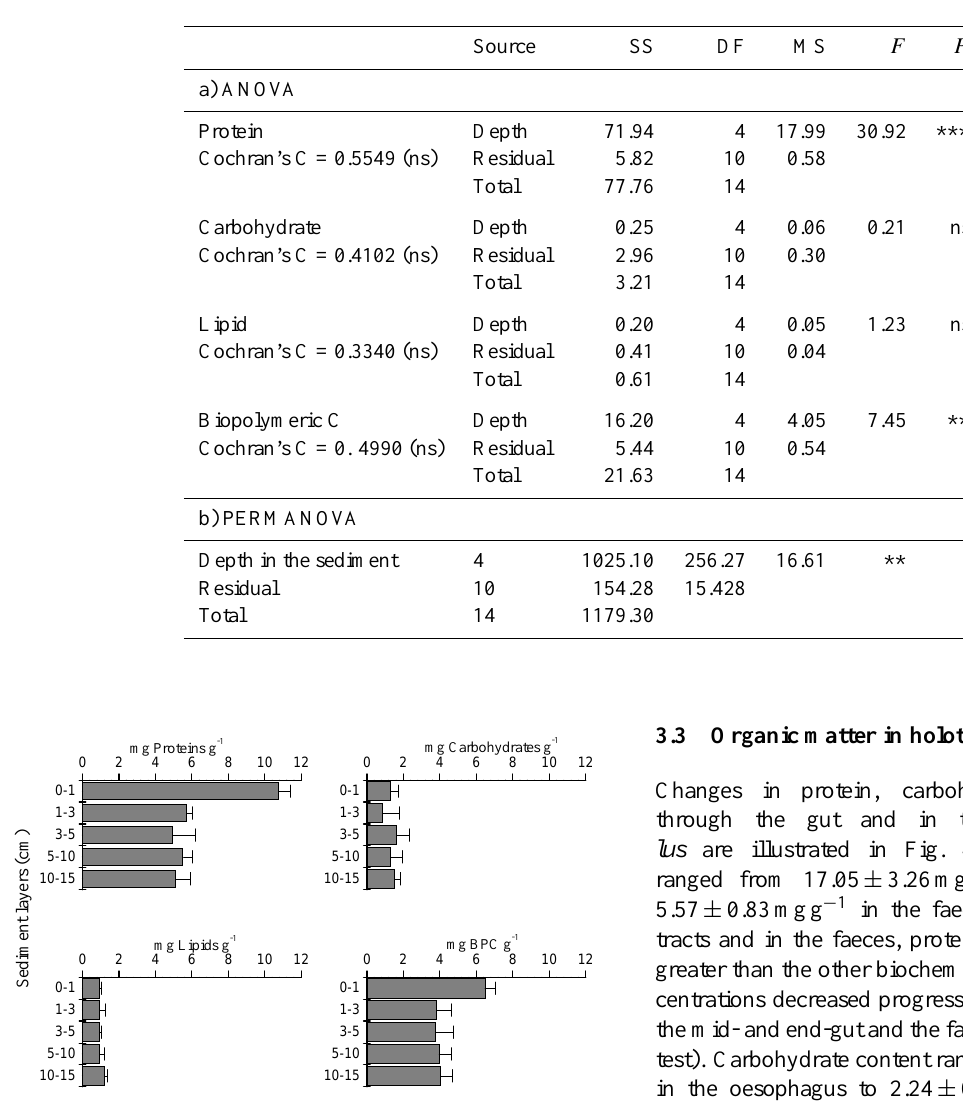
Table 2. Results of the ANOVA (a) and PERMANOVA (b) tests carried out to ascertain differences in the quantity (ANOVA) and biochemical composition (PERMANOVA) of sediment OM with changing depth in the sediment of the Nazar´e Canyon at 3500m depth. DF = degrees of freedom, SS = sum of squares; MS = mean square; F = F statistic; P = probability level; *** P < 0 . 001; ** = P < 0 . 01; SNK = Student- Newman-Keuls post-hoc comparisons tests; ns = not significant; na = not applicable. Reported are also the results of the Cochran’s C test: ns = not significant.